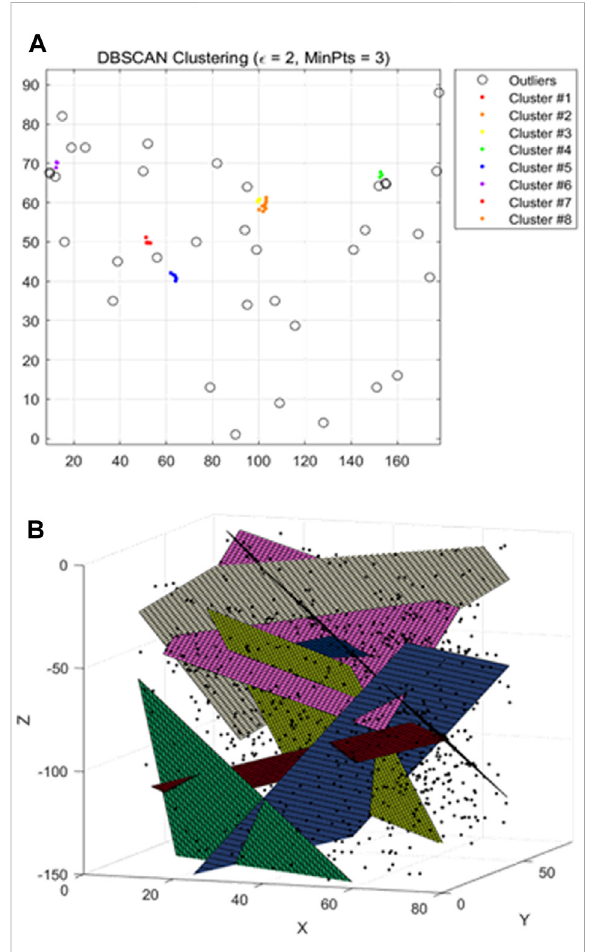
FIGURE 10 (A) Result of orientation clustering using the density-based spatial clustering of applications with noise (DBSCAN) method in the fi rst iteration. Events associated with labels were classi fi ed as orientation clusters and outliers. (B) Result of the re- estimatedmodel inthe fi rstiteration. Extractedplanes weresimilar to those of the true model from among data with many outliers.